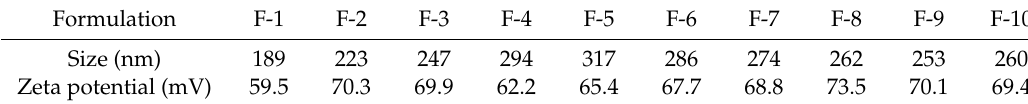
Table 3. Size and zeta potential of each formulation.